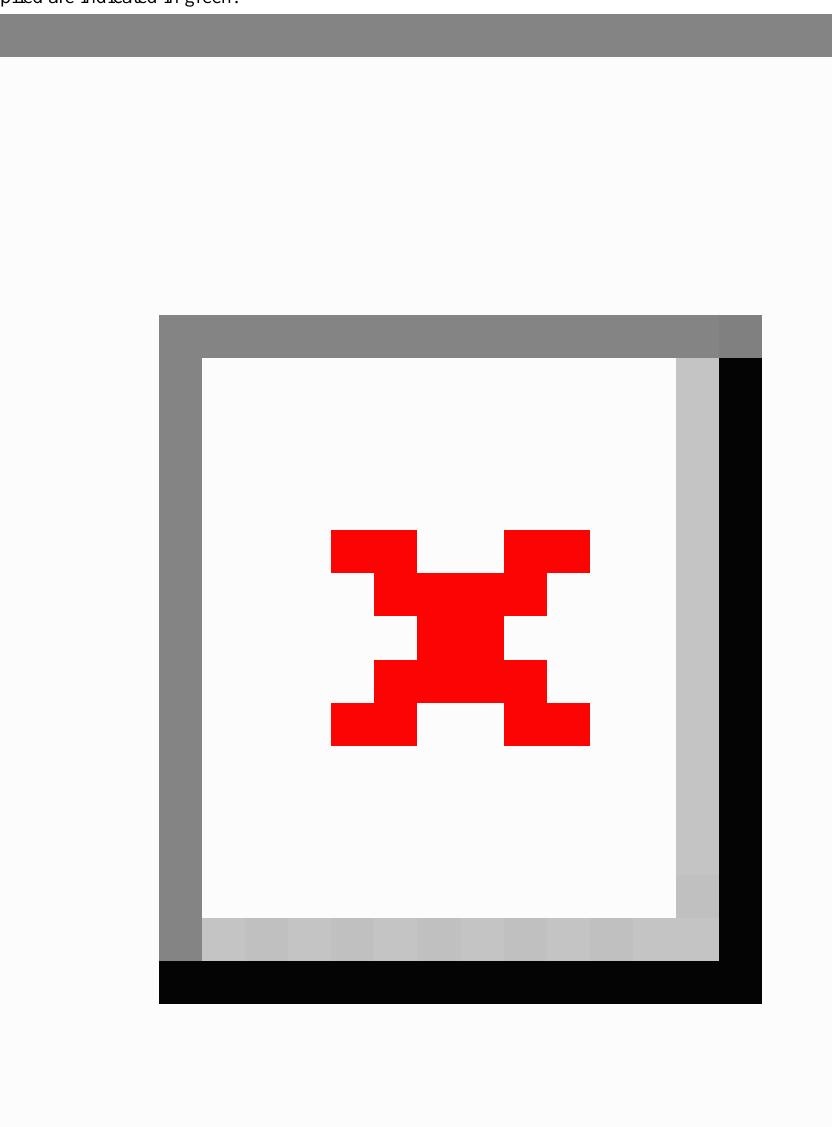
Figure 3. Example of messages. (A) Causality term associated with right section. (B) Causality term associated with left section. The sections in which the topic model is applied are indicated in